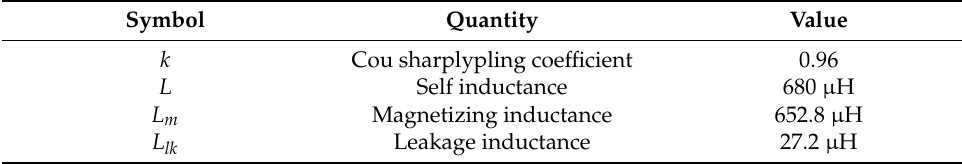
Table 3. Parameters of the coupled inductor.